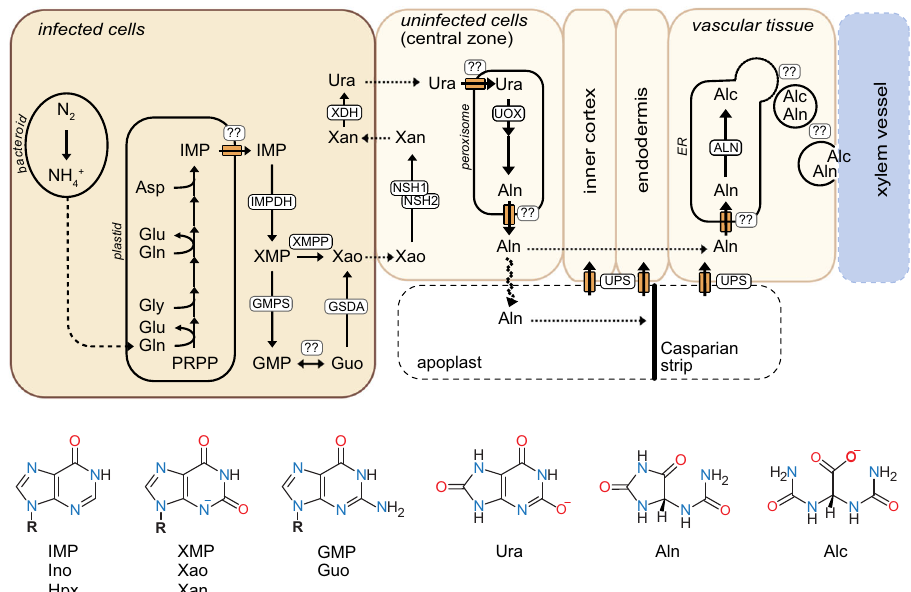
Fig.7|Updatedmodelforureidebiosynthesisandexportinbeannodules. The model integrates our experimental data with the current knowledge but